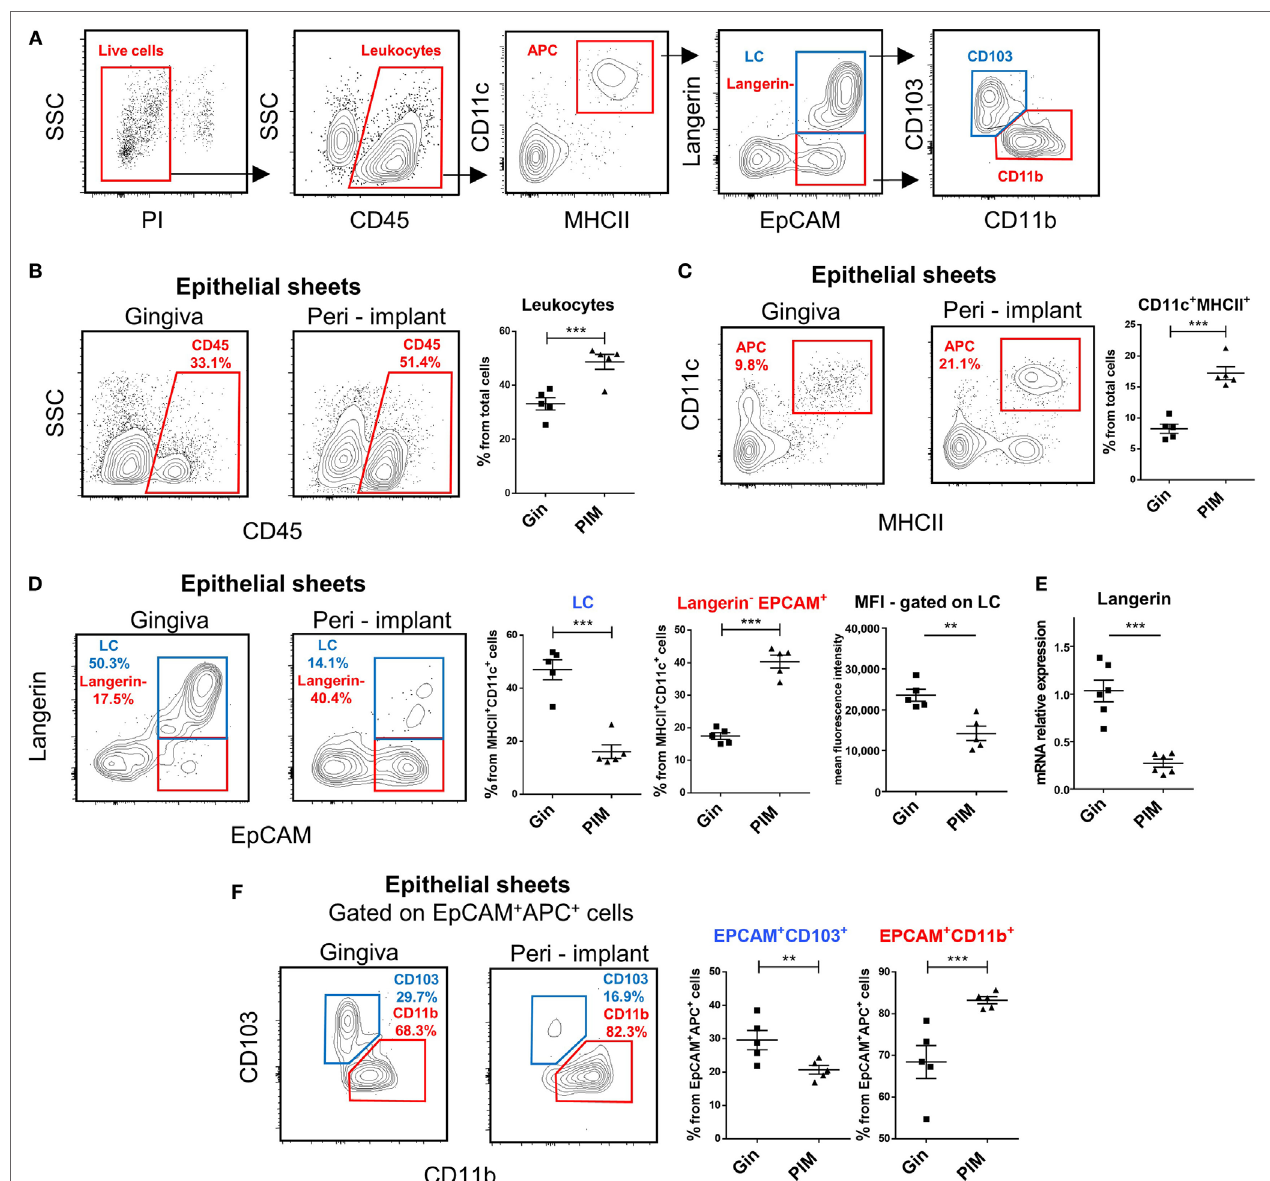
FigUre 2 | Decreased frequencies of terminally differentiated Langerhans cells (LCs) in the peri-implant epithelium. (a) Gating strategy to identify LCs and their precursors in the tissue using flow cytometry. (B,c) Frequencies of CD45 + leukocytes (B) and CD11c + MHCII + LC precursors (c) in the peri-implant and gingival epithelium 4 weeks after implant insertion. Representative FACS plots and graphs indicates percentages of CD45 + and CD11c + MHCII + cells from total cells, presented as the mean ± SEM ( n = 5 per group, each n represents oral tissues pooled from three individual mice). Data are representative of one out of three independent experiments. (D) Expression of langerin and EpCAM on CD11c + MHCII + cells in the peri-implant and gingival epithelium 4 weeks after implant insertion. Representative facs plots and graphs depicting the percentages of EpCAM + langerin + (LCs) and EpCAM + langerin neg cells form total CD11c + MHCII + cells are presented as the mean ± SEM ( n = 5 per group). Representative graph illustrate the mean fluorescence intensity (MFI) of langerin expression pre-gated on LCs in peri-implant and gingival epithelium presented as the mean ± SEM ( n = 5 per group). (e) Quantification of langerin mRNA in epithelial tissue prepared from peri-implant and gingival tissues using quantitative real-time PCR. Graph presents the fold change in gene expression normalized to non-implanted mice and presented as the mean ± SEM ( n = 6 mice per group). Data are representative of one out of two independent experiments. (F) Expression of CD11b and CD103 in epithelial CD11c + MHCII + EpCAM + cells 4 weeks after implant insertion. Representative FACS plots and graphs illustrating the percentages of the noted subsets presented as the mean ± SEM ( n = 5 per group). ** p < 0.01, *** p <